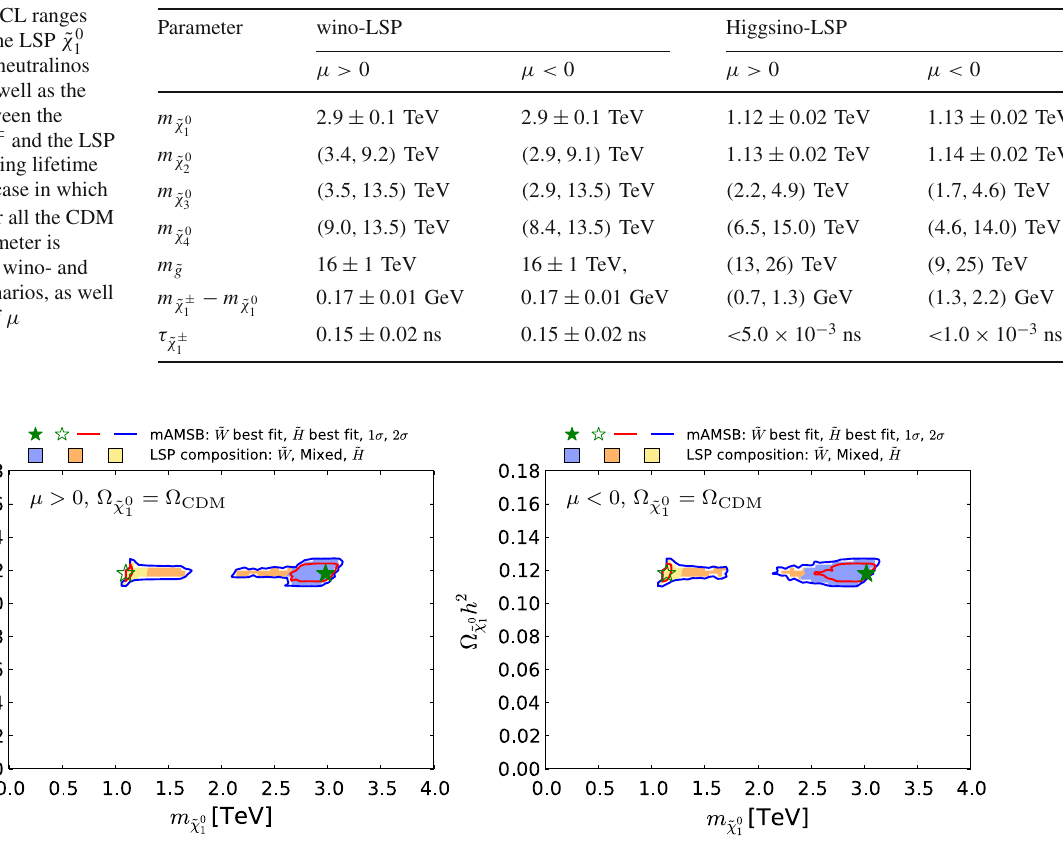
,(cid:4) h 2 ) planes for μ > 0 ( left panel ) and μ < 0 ( right panel ) assuming that all the CDM density is provided by the ˜ χ 0 Fig. 12 The ( m ˜ χ 0 ˜ χ 0 1 1 shadings are the same as in Fig.